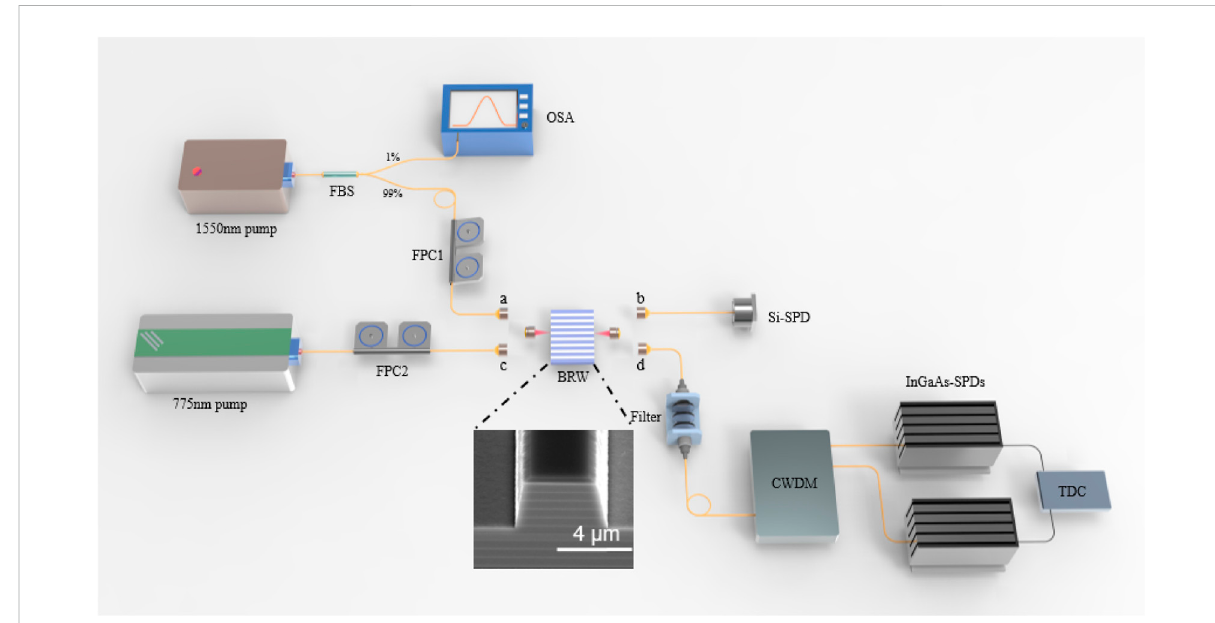
FIGURE 4 Schematic of the experiment setup for SHG and SPDC. Inset shows the scanning electron microscope image of the fabricated BRW sample. Abbreviations of components: BRW, Bragg re fl ection waveguide; FBS, fi ber optic beam-splitter; FPC, fi ber polarization controller; OSA,